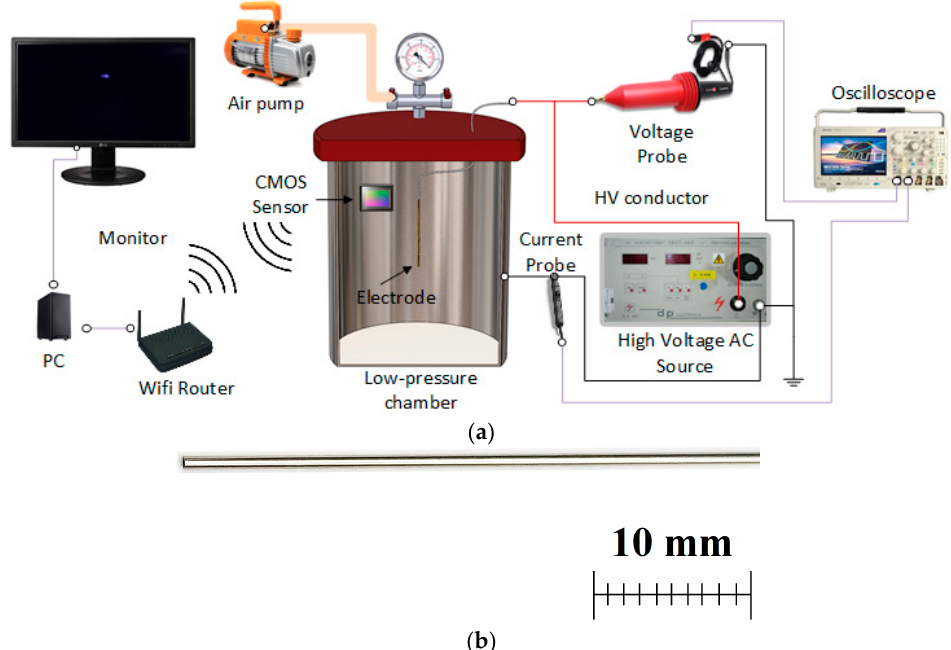
Figure 4. ( a ) Sketch of the experimental setup used to reduce the pressure and generate electric discharges. ( b ) Needle-plane air gap (stainless steel, diameter = 0.8